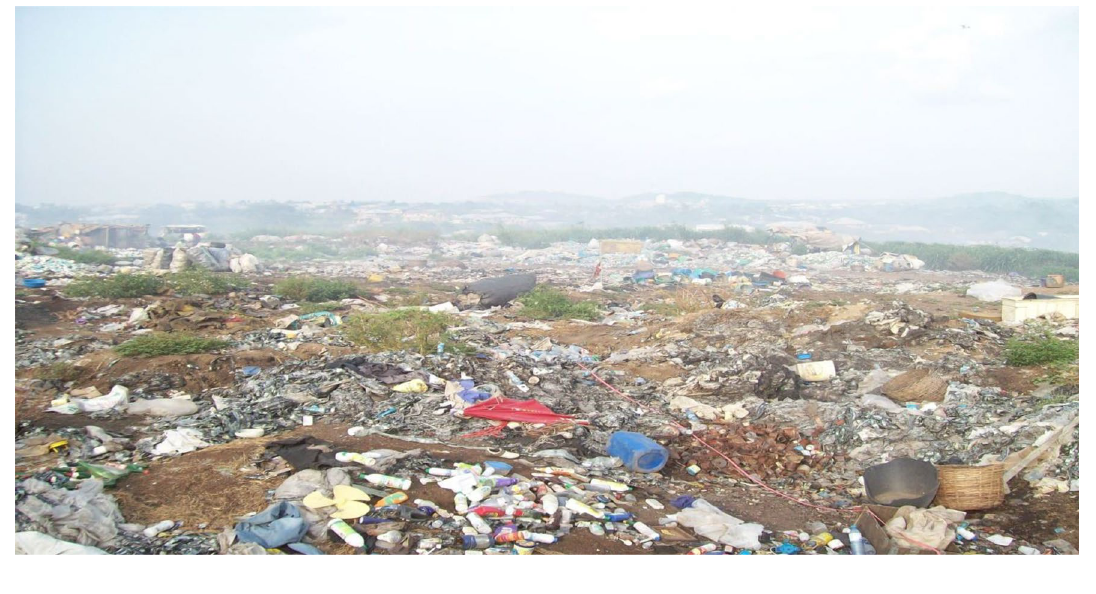
Fig. 1 General overview of Ajakanga dumpsite